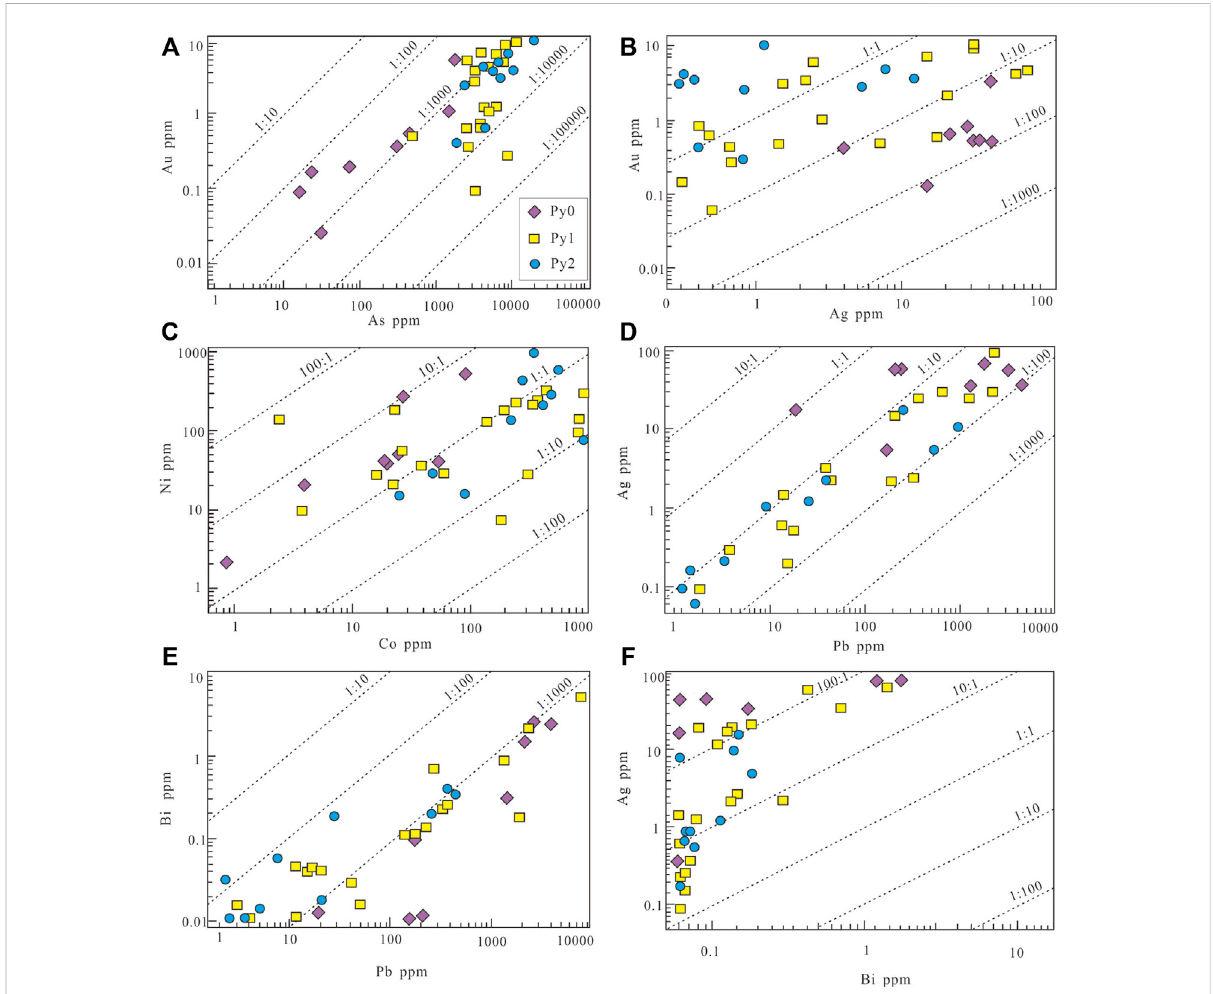
FIGURE 10 Binaryplotsof (A) Au vs. As, (B) Au vs. Ag, (C) Bi vs .Co, (D) Ag vs. Pb, (E) Bi vs .Pb,and (F) Ag vs. BiinPy0,Py1,andPy2fromtheHouge ’ zhuanggold